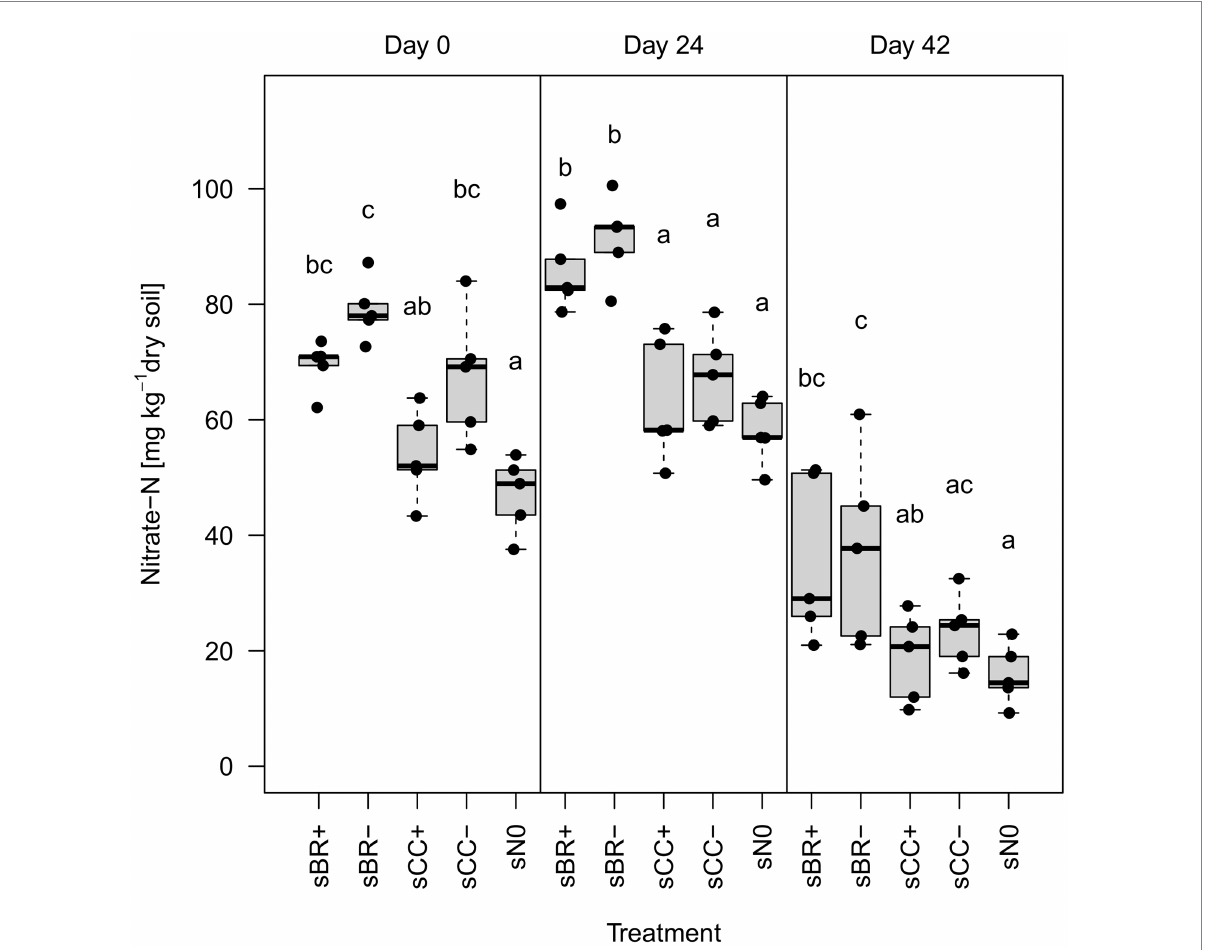
FIGURE 1 Nitrate-N (NO 3 − -N) content in the different fertilizer-amended soils and in the no-fertilizer treatment. Distinct lower-case letters indicate significant ( p < 0.05, n = 5) differences among treatments for the same sampling date. sBR+, soil fertilized with BSFL residue; sBR-, soil fertilized with sterile BSFL residue; sCC+, soil fertilized with conventional compost; sCC-, soil fertilized with sterile conventional compost; sN0, no-fertilizer